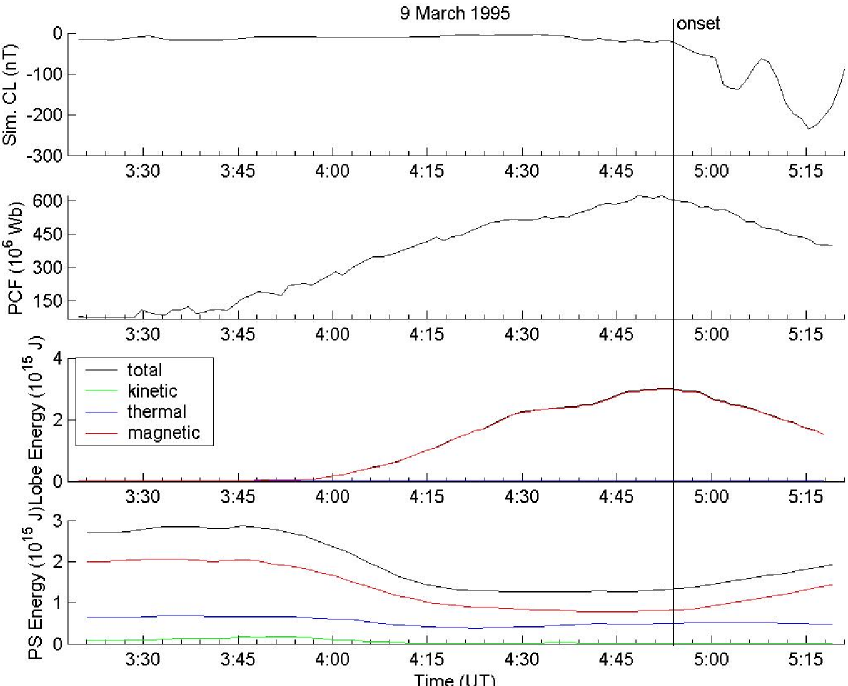
Fig. 3. Panel 1 shows the simulated CL index, panel 2 shows the polar cap flux. The evolution of total (black), kinetic (green), thermal (blue), and magnetic (red) energies in lobe and plasma sheet is seen in panels 3 and 4,